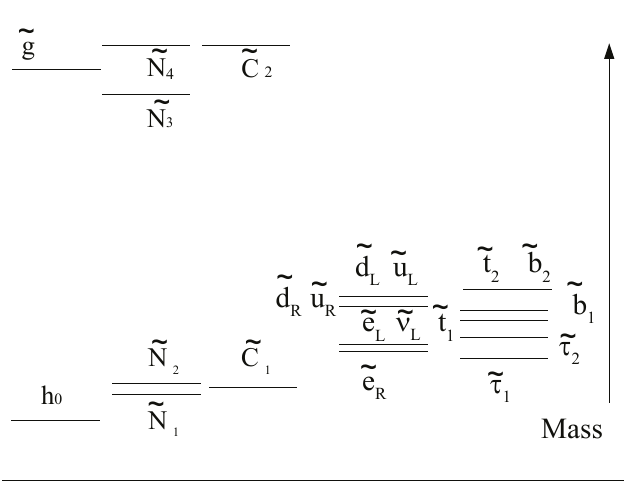
Figure 1 . Illustration of a typical Antisplit SUSY spectrum with extremely heavy gauginos and light